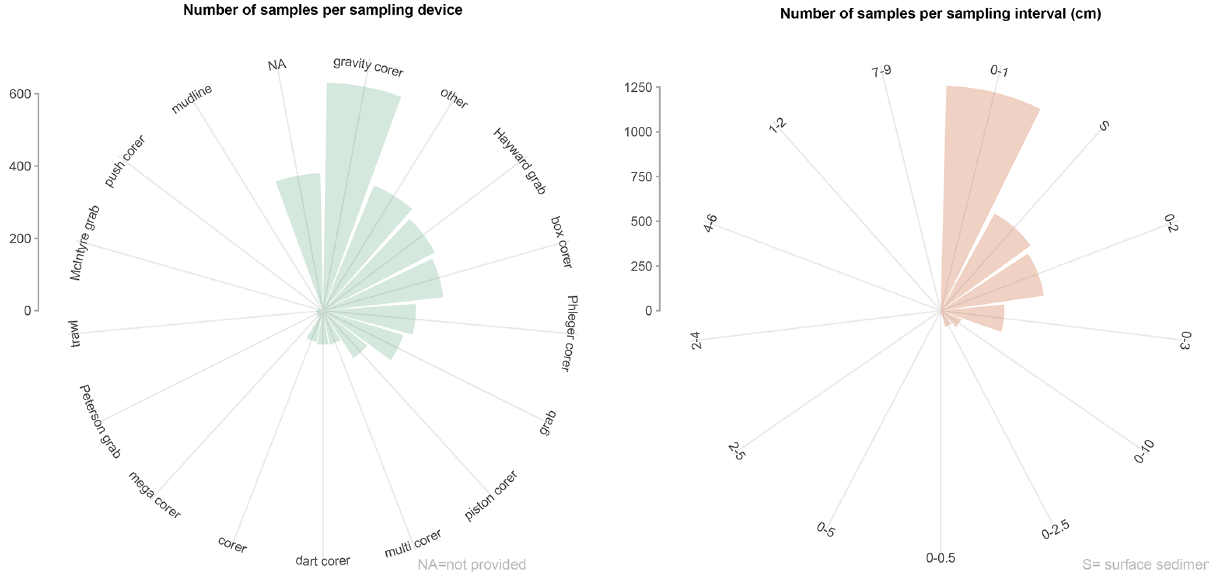
Figure 3. Sampling devices and sampling intervals in BENFEP_v1. The distribution of sampling devices is calculated using the “dev_1” column (see Tables C1 and C2 for more information). The graphs were elaborated with the “tidyverse” package (Wickham et al., 2019) using R version 4.2.1 (R Core Team,